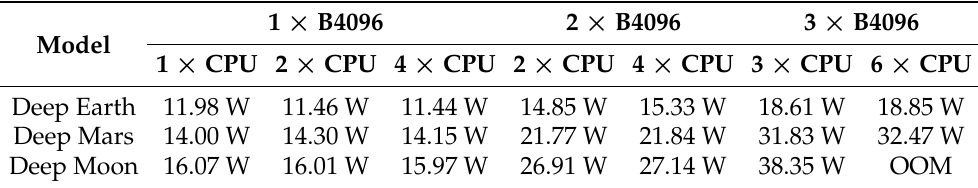
Table 20. The peak power consumption during benchmarks for B4096 DPU